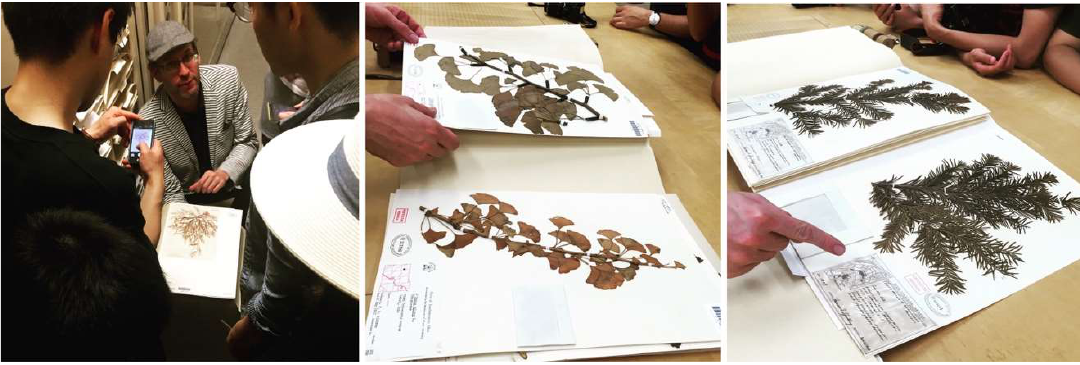
Figure 2. Students study the scientific collection of dried plants at the University and Jepson Herbaria.